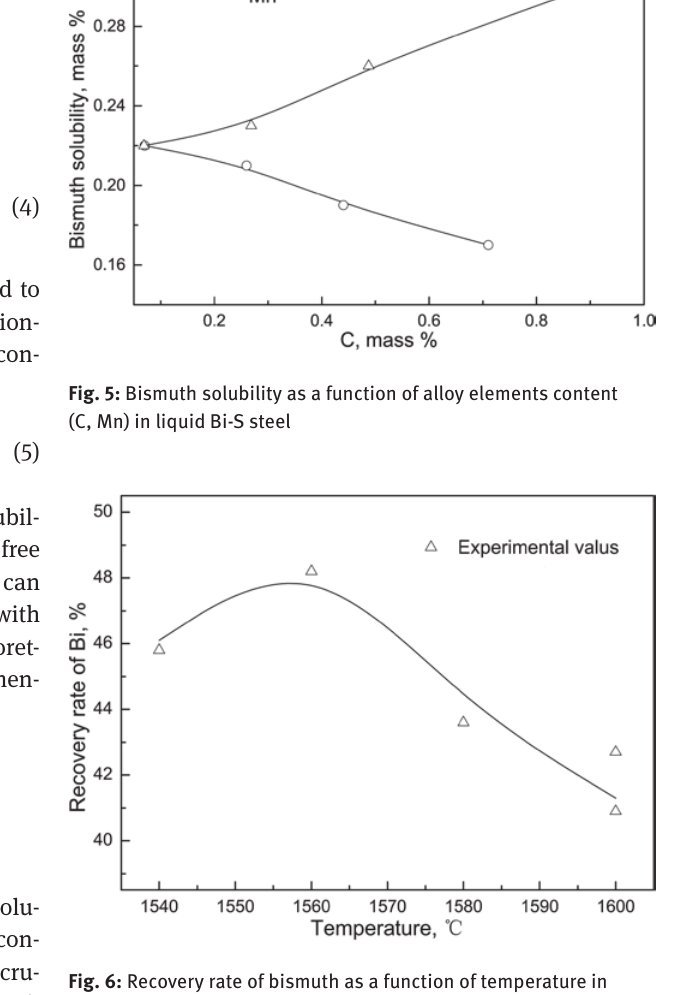
Fig. 6: Recovery rate of bismuth as a function of temperature in liquid Bi-S